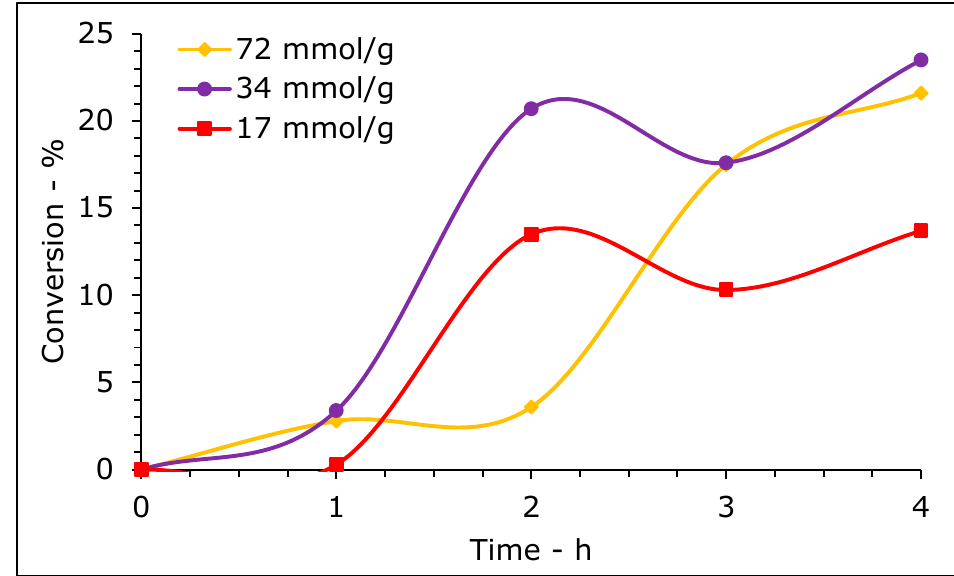
Figure 6. Photo-reduction of NO 3 − under LED lamp using 0.1% Ag/FSP as photocatalyst, with various substrate/cat ratio (17–72 mmol NO3 − /g cat ), NaNO 3 (1.7 mM), pH 5, rt and 1000 mL of solution (Reactor 2).